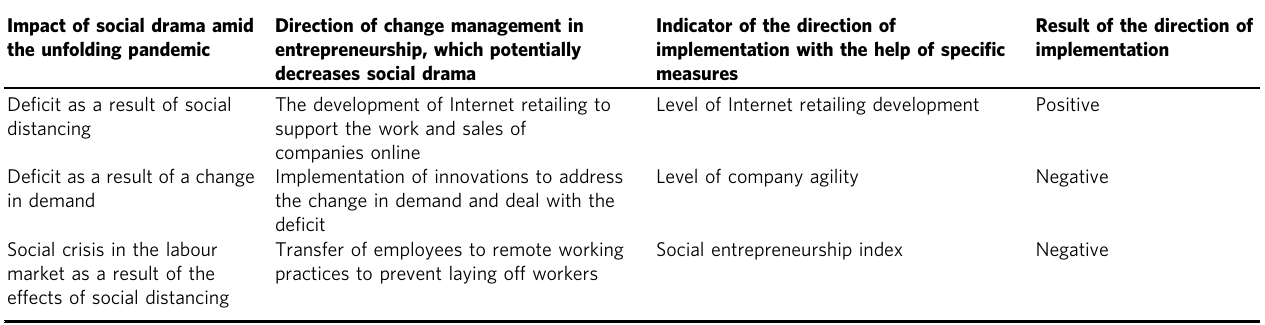
Table 7 International experience of entrepreneurial change management measures in 2020 –